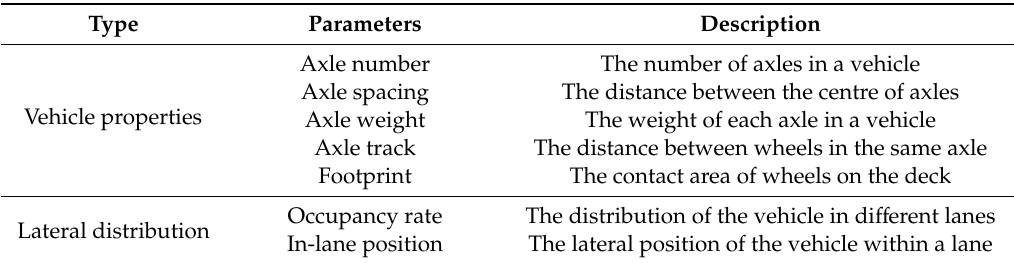
Table 2. Parameters in the framework of the stochastic tra ffi c